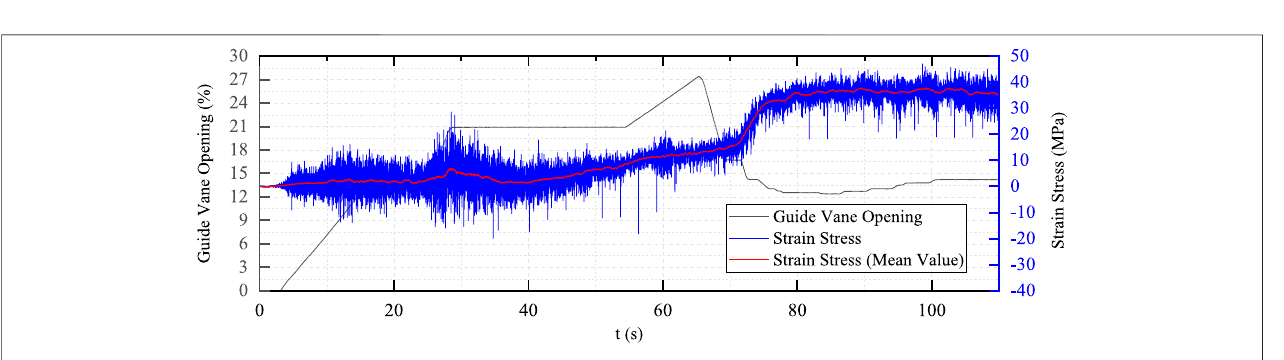
FIGURE 15 | The stress curve of the blade back in the direction of vertical water fl ow (optimized control mode).